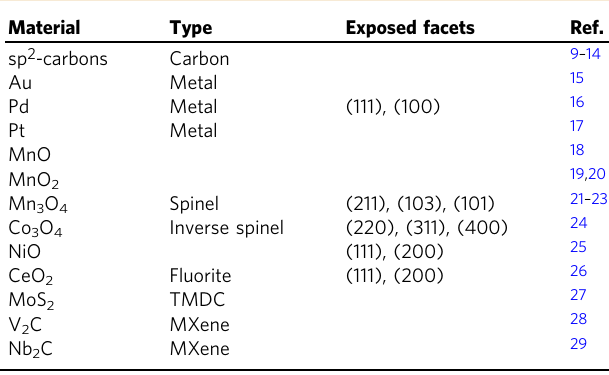
Table 1 Nanomaterials catalytically scavenging O 2 (cid:129) − and having atomistic-level structural information for the computational